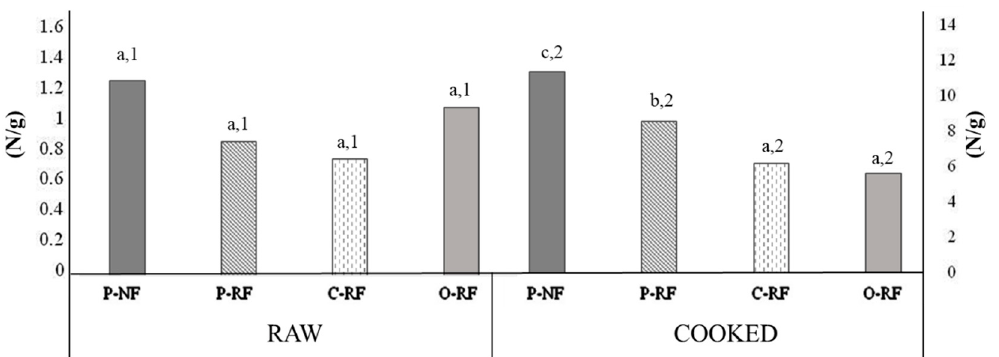
Figure 4. Kramer shear force (KSF, N/g) of raw and grilled cooked longanizas. For samples denominations, see Figure 1. Different letters (a, b, c), for the same treatment of samples (raw or cooked), indicate significant differences ( p < 0.05) between different formulations (P-NF, P-RF, C-RF and O-RF). Different numbers (1,2) indicate significant differences ( p < 0.05) between formulations and treatments for each type of sample.